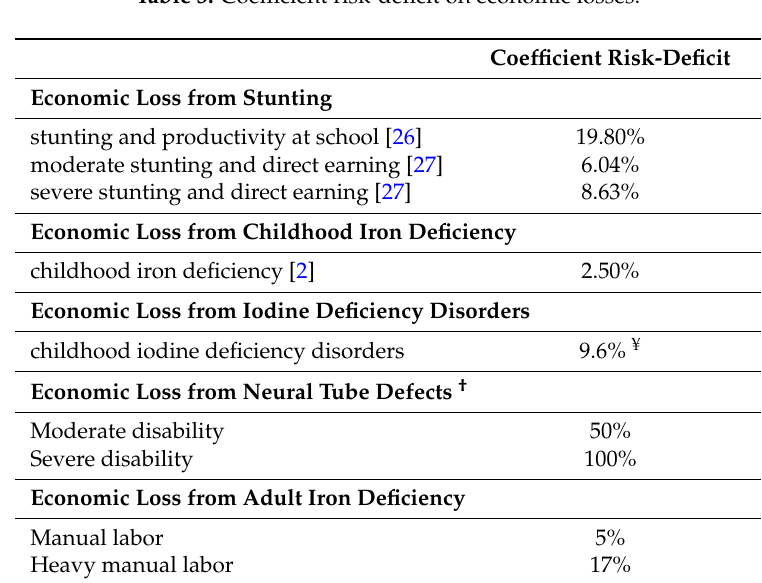
Table 3. Coefficient risk-deficit on economic